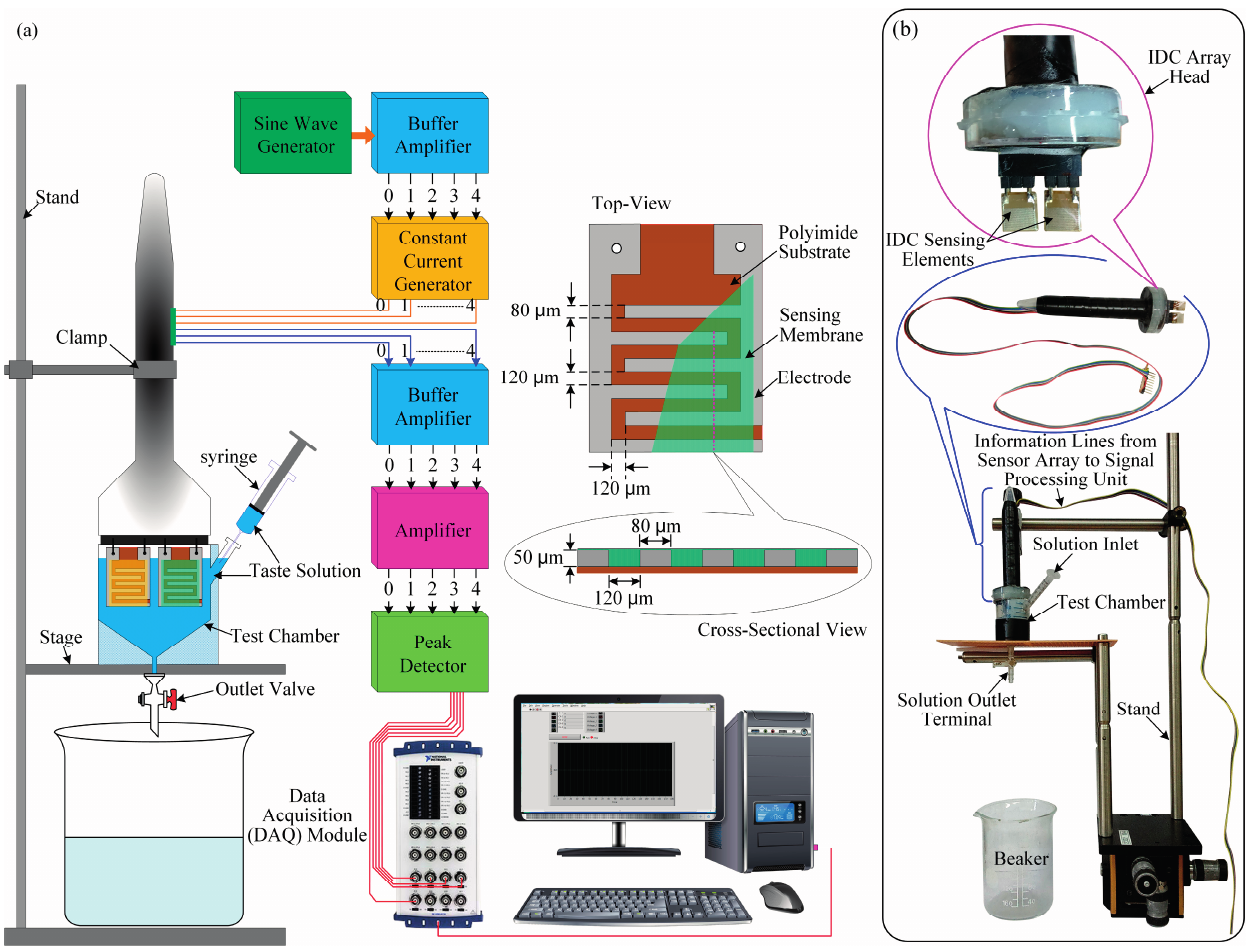
Figure 6. Experimental setup of the IDC array taste sensing system: ( a ) schematic diagram of the taste sensing system; and ( b ) photograph of the different parts of the IDC sensor